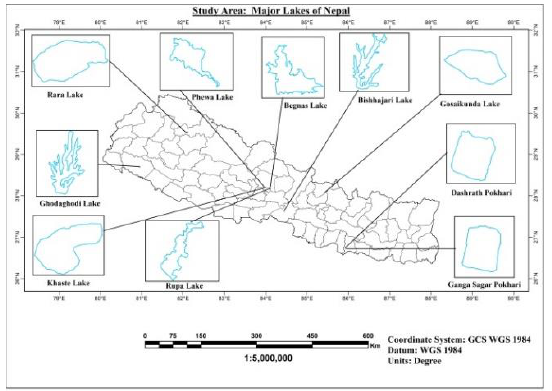
Figure 1. Study Area: Major Lakes of Nepal